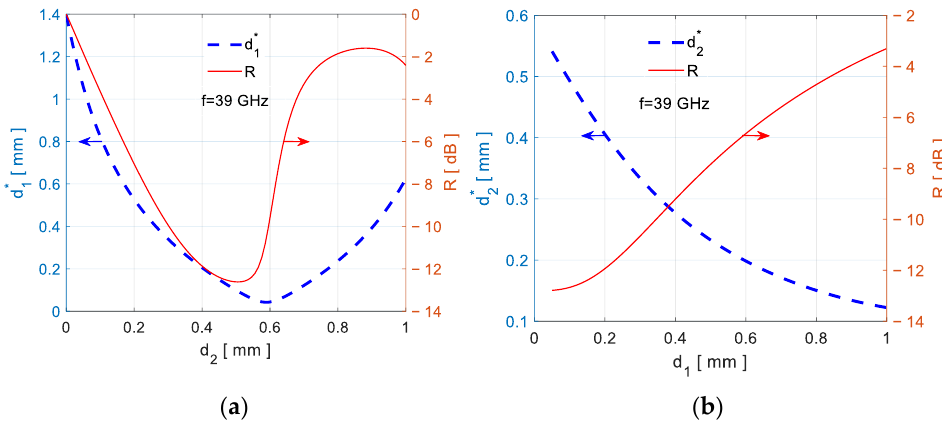
Figure 7. Optimal thicknesses 𝑑 1∗ ( 𝑑 2 ) ( a ) and 𝑑 2∗ (𝑑 1 ) ( b ) at target frequency of 39 GHz.